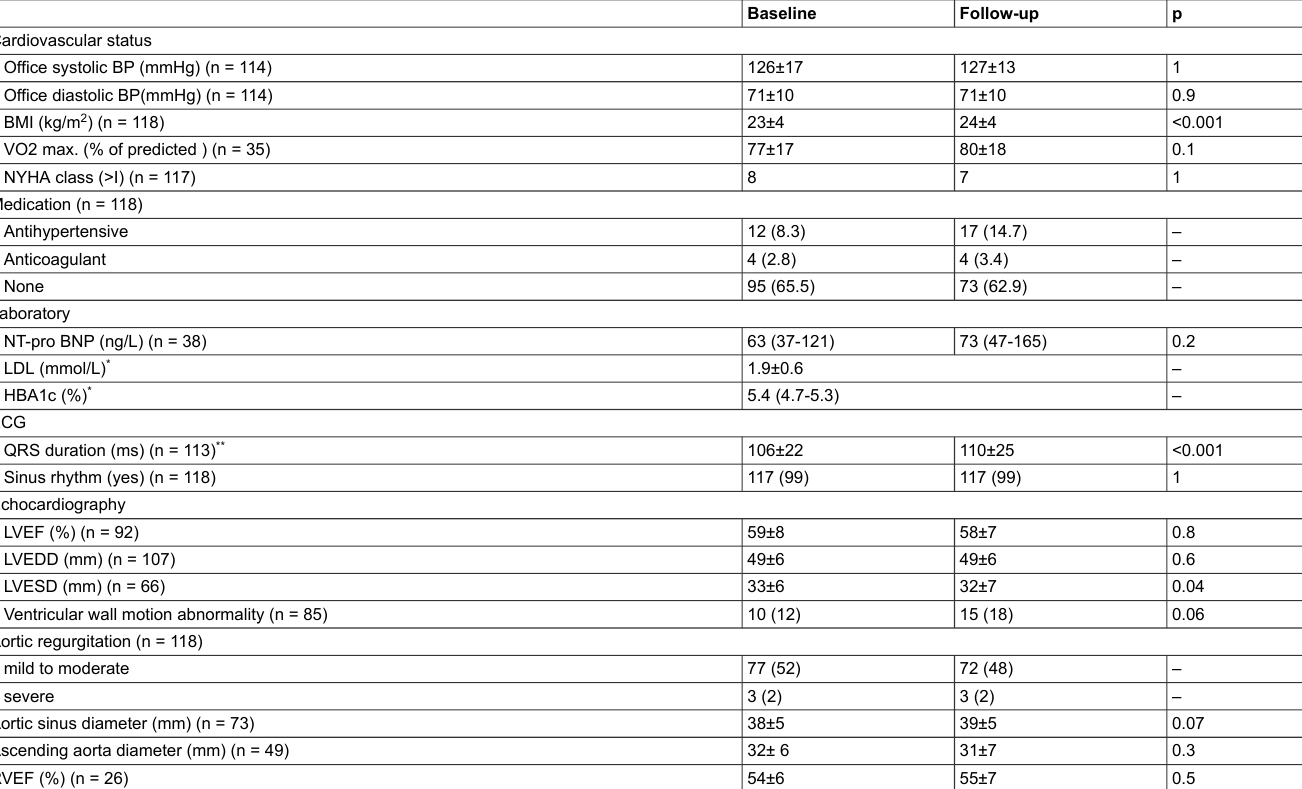
Table S2: Functional and cardiovascular status over